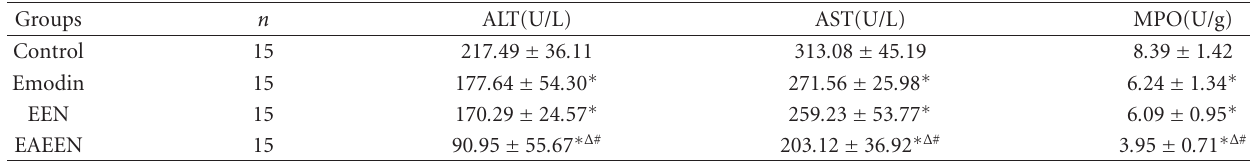
Table 4: Levels of ALT, AST, and hepatic MPO activity in 4 groups (EEN: early enteral nutrition. EAEEN: emodin-assisted early enteral nutrition. ALT: glutamic pyruvic transaminase. AST: glutamic oxaloacetic transaminase. MPO: myeloperoxidase).